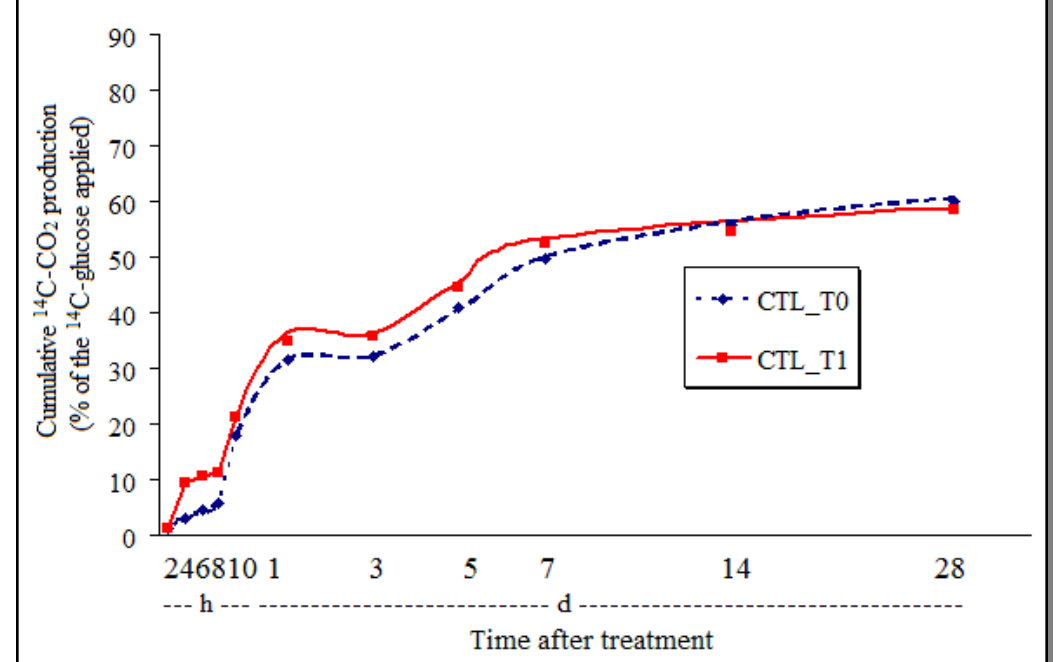
Figure 5. Cumulative production of 14 C-CO with chlorothalonil (CTL_T0 = control; CTL_T1 = chlorothalonil; h = hours; d =